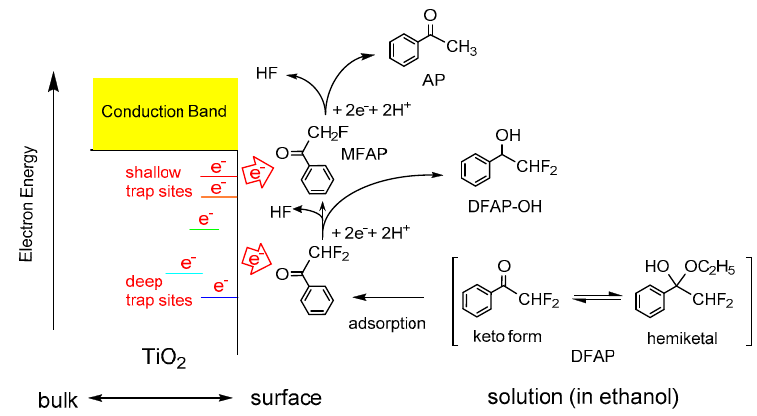
Figure 6. Schematic illustration on the photocatalytic reduction of 2,2-difluoromethyacetophenone (DFAP) on the UV irradiated TiO 2 . Reprinted with permission from reference [80]. Copyright (2016) Elsevier B.V.